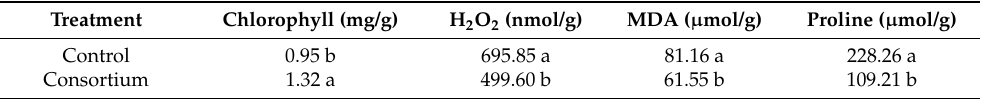
Table 2. Effect of bacterial inoculation on chlorophyll, proline, MDA and H 2 O 2 content of M. sativa leaves under NaCl stress. Values with different letters are significantly different ( p = 0.05). Means that do not share a letter are significantly different.